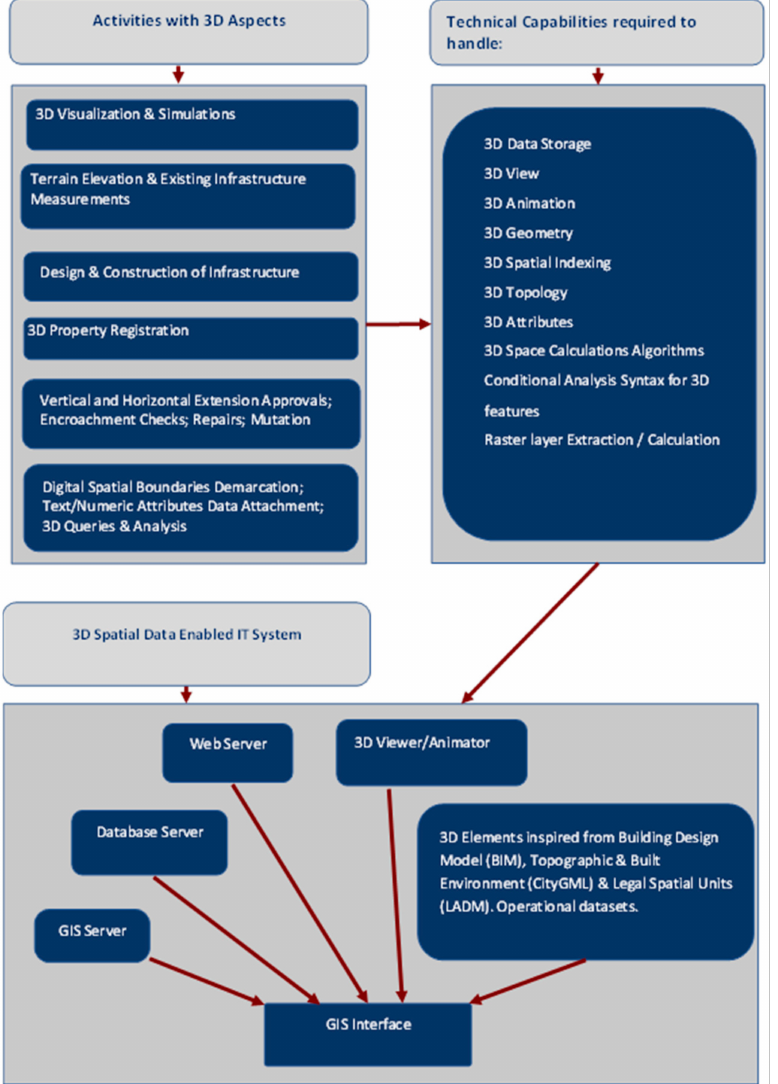
Figure 7. Overview of information technology framework for 3D land planning and development